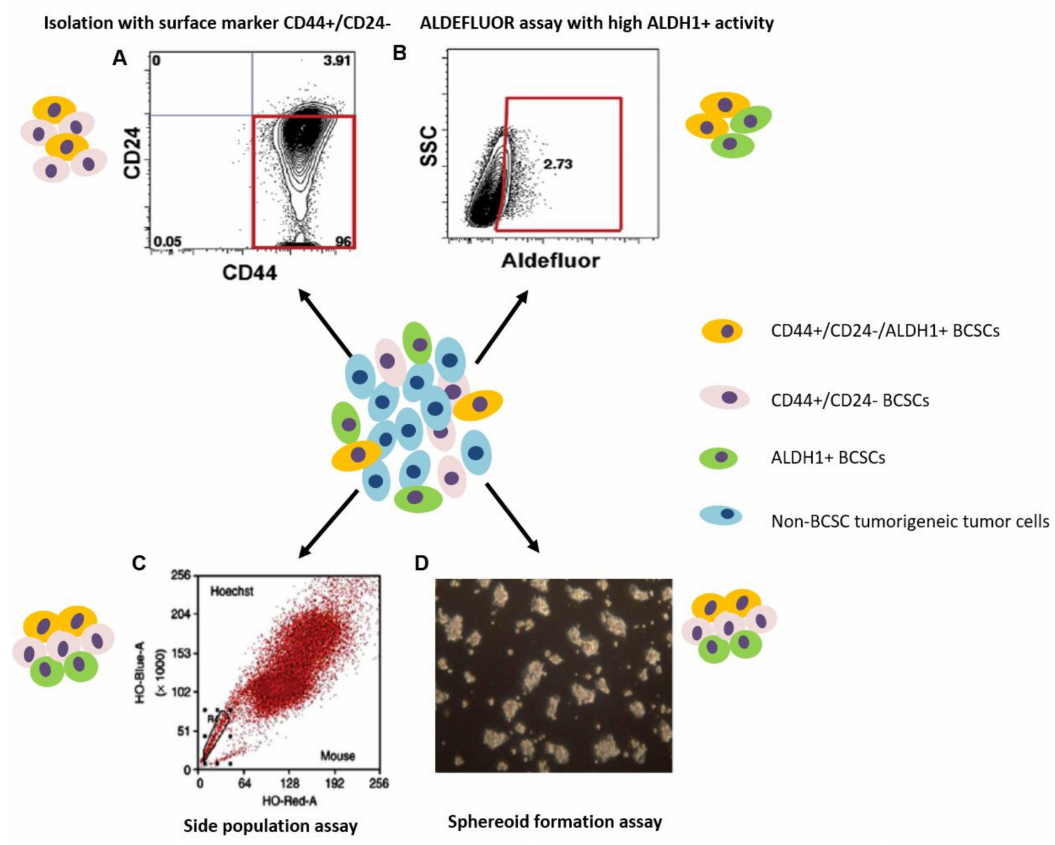
Figure 3. Major BCSC identification and isolation methods: isolation based on ( A ) BCSC surface assay based on high ABC transporter expression, and ( D ) spheroid formation assay based on the CSC capability of forming spheres. Cells with di ff erent colors to depict the heterogeneity of BC tumors and BCSC subtypes. The isolated BCSCs from all four methods have the capability to form heterogeneous tumors in vivo. SSC: side-scattered light. This figure is modified based on previous reviews,